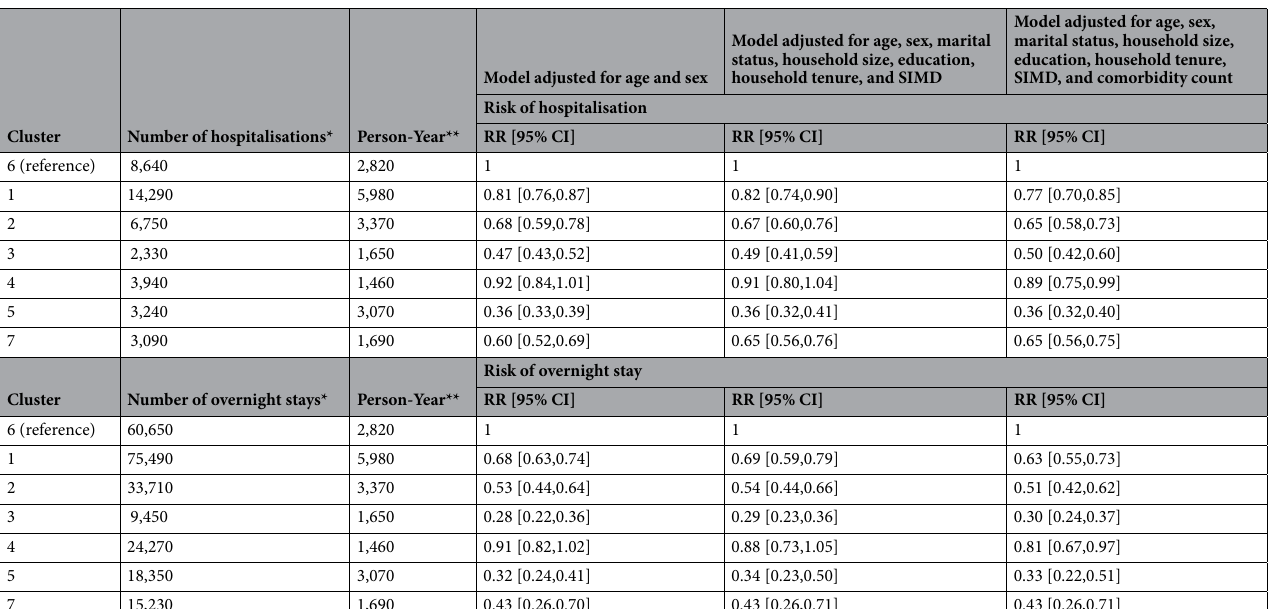
Table 4. Cluster differences in risk of hospitalisations and overnight stays following multimorbidity onset. Source: Scottish Longitudinal Study. * Number of hospitalisations and overnight stays are calculated over 5 years post multimorbidity onset. ** Person-year were calculated over 5 years post multimorbidity onset and adjusted for any exit or death within that period.